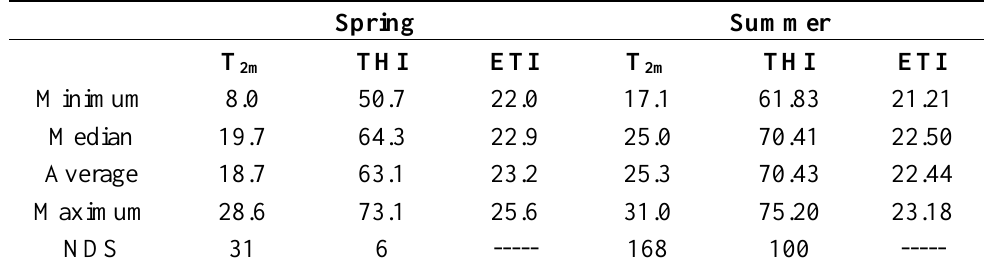
Figure 3. Statistics of milk parameters. Lines inside the box plots show the median and points show the season averages of milk compounds (Milk yield (Kg/Year), fat (g/100 mL), protein (g/100 mL) in fresh product) in spring (blue boxes) and summer (red boxes) from 2002 to 2010. Table 1. Temperature in two meter height (T 2m in °C), Temperature Humidity Index (THI) and Equivalent Temperature Index (ETI) and number of days that cow is under stress (NDS), during 2002 to 2010 in spring and summer.